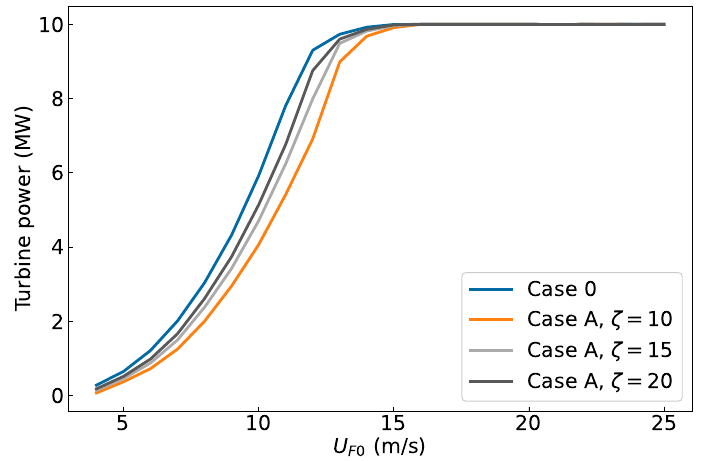
Figure 10. Comparison of farm-average turbine power between Case 0 and Case A (with a fixed wind direction of 0°).